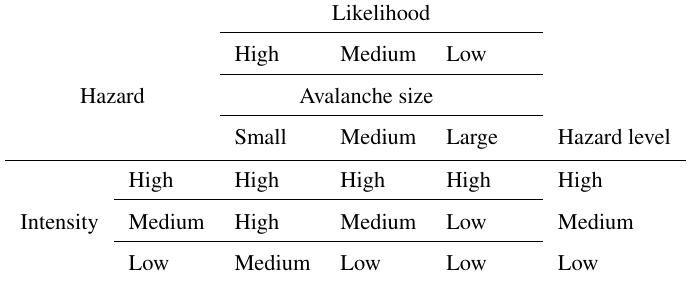
Table 3. Flood hazard